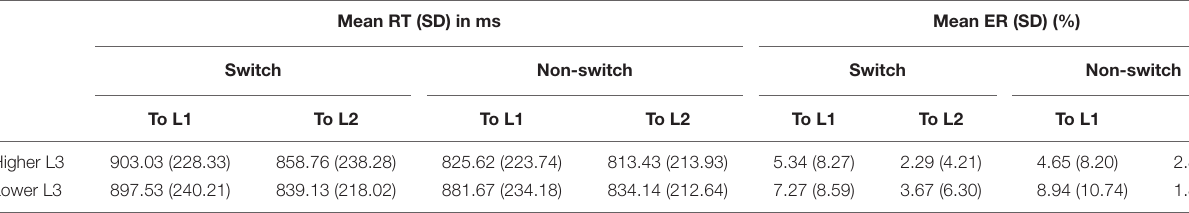
TABLE 2 | RTs and ERs in experiment 1.